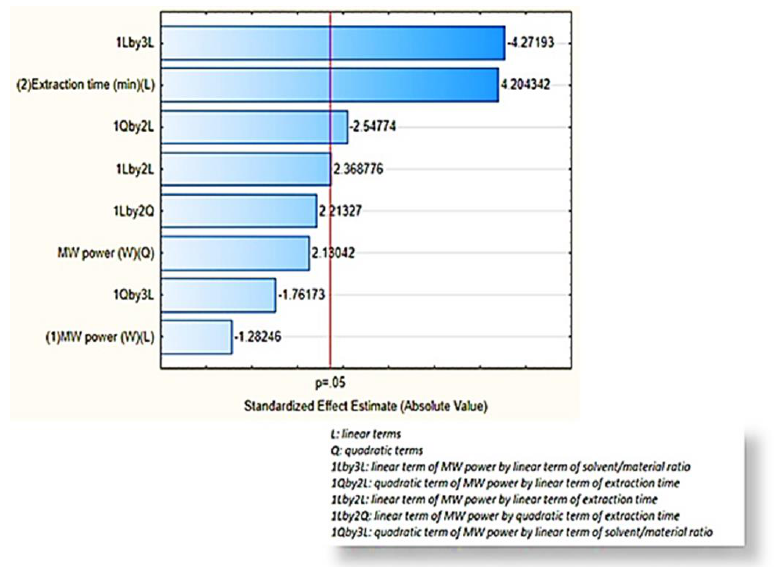
Figure 1. Pareto chart of the BBD model.